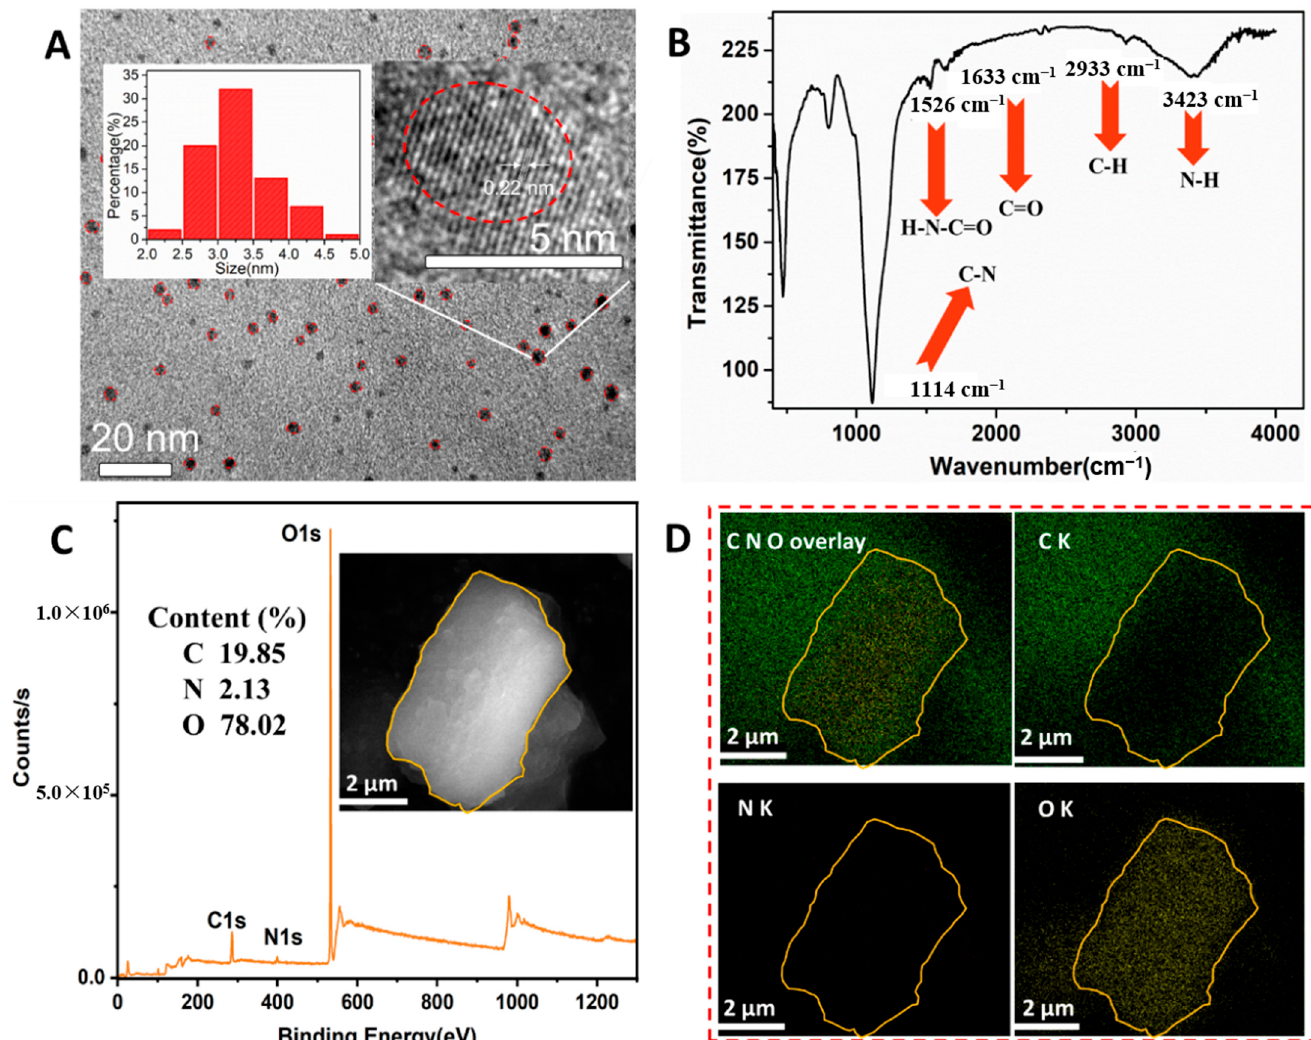
Figure 2. ( A ) TEM image of N-CQDs, inset: diameter distribution of N-CQDs and high-resolution TEM of a single N-CQD particle; ( B ) FT-IR spectrum of N-CQDs; ( C ) XPS spectrum of N-CQDs, inset: scanning electron microscopy (SEM) image of N-CQDs powder; and ( D ) EDS mapping images of elements on the surface of N-CQDs.